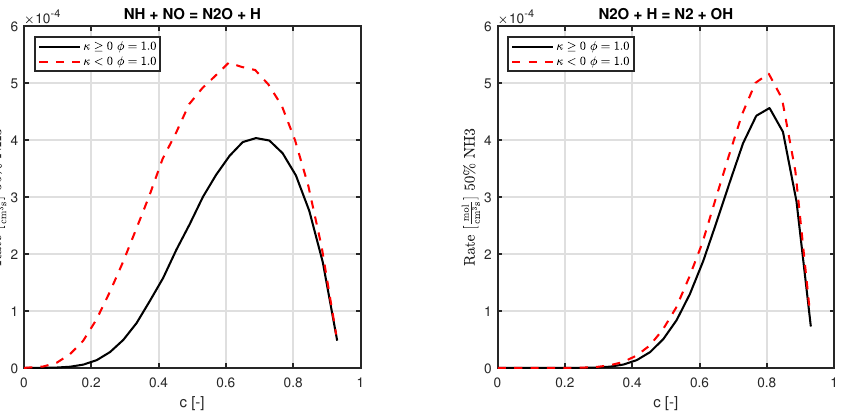
Figure 12. Conditional averages split by the sign of the curvature for reaction rates of N 2 O reactions for 50% ammonia at a stoichiometric equivalence ratio.